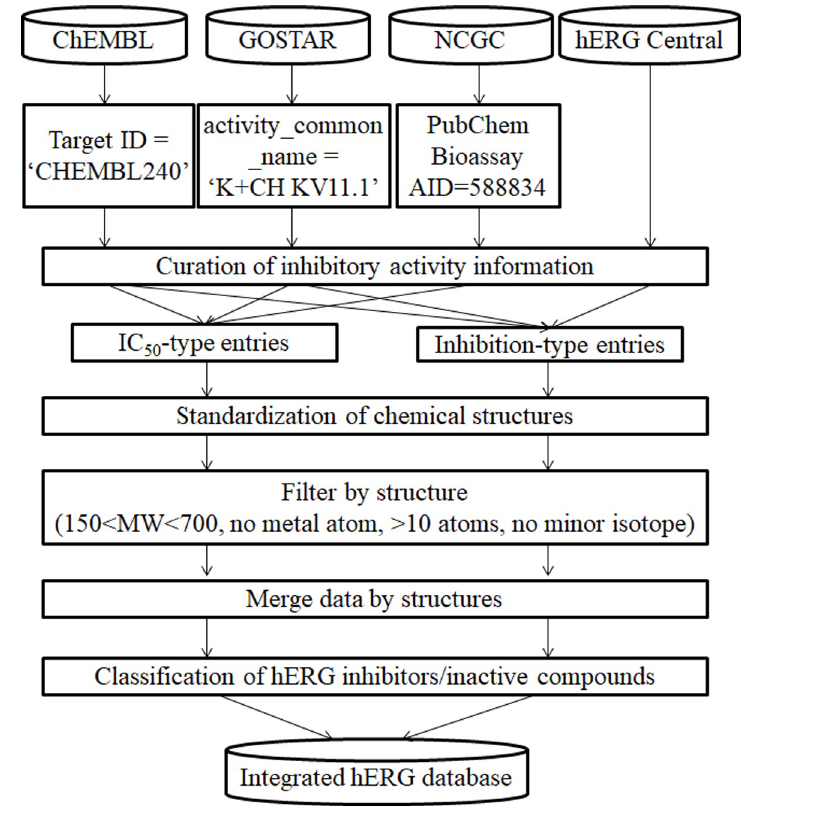
Fig 1. Schematic procedure of the database